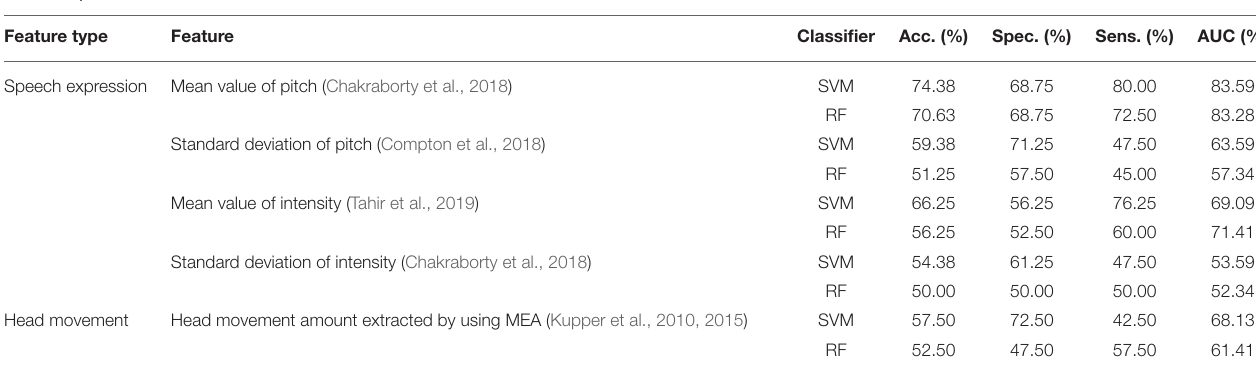
TABLE 4 | Results of the state-of-the-art. Feature